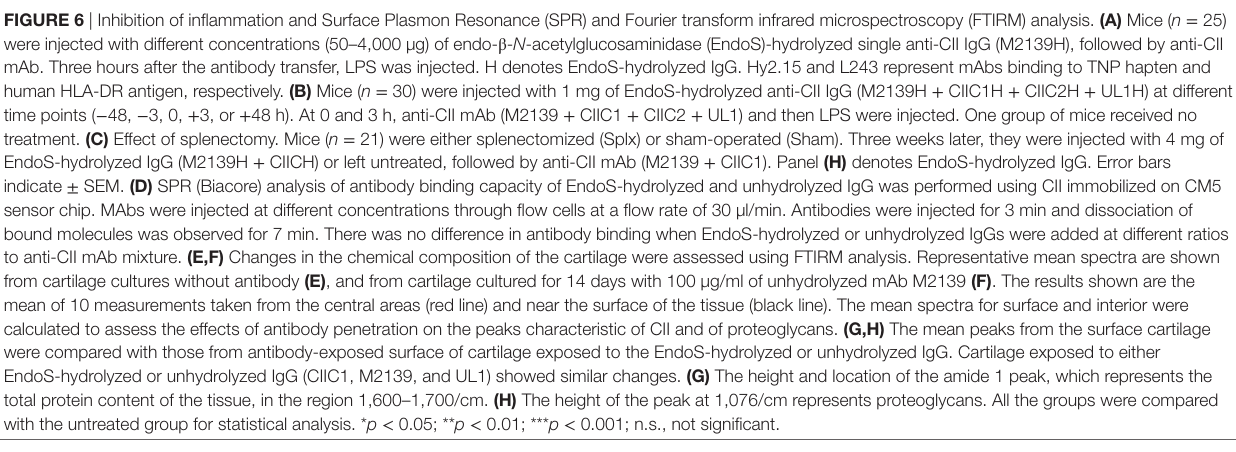
FigUre 6 | Inhibition of inflammation and Surface Plasmon Resonance (SPR) and Fourier transform infrared microspectroscopy (FTIRM) analysis. (a) Mice ( n = 25) were injected with different concentrations (50–4,000 µg) of endo- β - N -acetylglucosaminidase (EndoS)-hydrolyzed single anti-CII IgG (M2139H), followed by anti-CII mAb. Three hours after the antibody transfer, LPS was injected. H denotes EndoS-hydrolyzed IgG. Hy2.15 and L243 represent mAbs binding to TNP hapten and human HLA-DR antigen, respectively. (B) Mice ( n = 30) were injected with 1 mg of EndoS-hydrolyzed anti-CII IgG (M2139H + CIIC1H + CIIC2H + UL1H) at different time points ( − 48, − 3, 0, + 3, or + 48 h). At 0 and 3 h, anti-CII mAb (M2139 + CIIC1 + CIIC2 + UL1) and then LPS were injected. One group of mice received no treatment. (c) Effect of splenectomy. Mice ( n = 21) were either splenectomized (Splx) or sham-operated (Sham). Three weeks later, they were injected with 4 mg of EndoS-hydrolyzed IgG (M2139H + CIICH) or left untreated, followed by anti-CII mAb (M2139 + CIIC1). Panel (h) denotes EndoS-hydrolyzed IgG. Error bars indicate ± SEM. (D) SPR (Biacore) analysis of antibody binding capacity of EndoS-hydrolyzed and unhydrolyzed IgG was performed using CII immobilized on CM5 sensor chip. MAbs were injected at different concentrations through flow cells at a flow rate of 30 µl/min. Antibodies were injected for 3 min and dissociation of bound molecules was observed for 7 min. There was no difference in antibody binding when EndoS-hydrolyzed or unhydrolyzed IgGs were added at different ratios to anti-CII mAb mixture. (e,F) Changes in the chemical composition of the cartilage were assessed using FTIRM analysis. Representative mean spectra are shown from cartilage cultures without antibody (e) , and from cartilage cultured for 14 days with 100 µg/ml of unhydrolyzed mAb M2139 (F) . The results shown are the mean of 10 measurements taken from the central areas (red line) and near the surface of the tissue (black line). The mean spectra for surface and interior were calculated to assess the effects of antibody penetration on the peaks characteristic of CII and of proteoglycans. (g,h) The mean peaks from the surface cartilage were compared with those from antibody-exposed surface of cartilage exposed to the EndoS-hydrolyzed or unhydrolyzed IgG. Cartilage exposed to either EndoS-hydrolyzed or unhydrolyzed IgG (CIIC1, M2139, and UL1) showed similar changes. (g) The height and location of the amide 1 peak, which represents the total protein content of the tissue, in the region 1,600–1,700/cm. (h) The height of the peak at 1,076/cm represents proteoglycans. All the groups were compared with the untreated group for statistical analysis. * p < 0.05; ** p < 0.01; *** p < 0.001; n.s., not